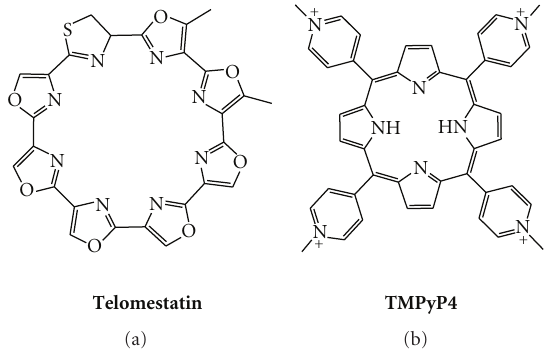
Figure 2: Chemical structures of telomestatin and TMPyP4 (with − as p -CH 3 (C 6 H 4 )SO 3